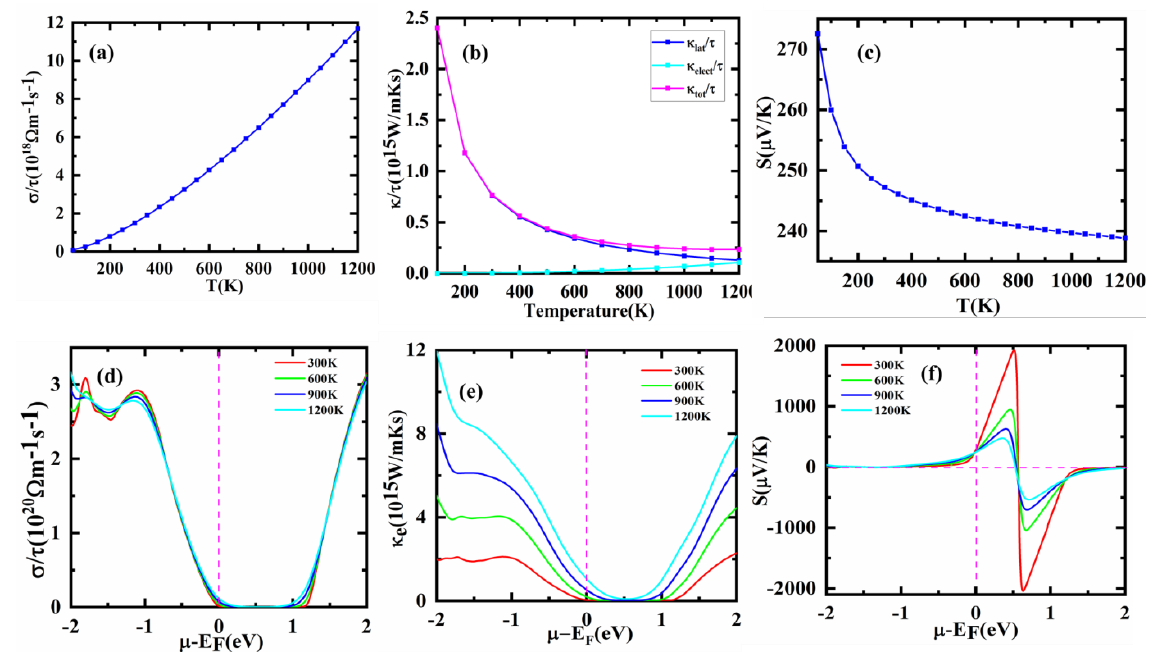
Figure 8. ( a ) Electrical conductivity, ( b ) thermal conductivity, ( c ) Seeback coefficient vs. temperature, ( d ) electrical conductivity, ( e ) thermal conductivity, and ( f ) Seeback coefficient vs. the chemical potential of cubic obtained using the nmBJ-GGA method. Table 5. Calculated thermoelectric properties at 300K for SnTiO 3 .